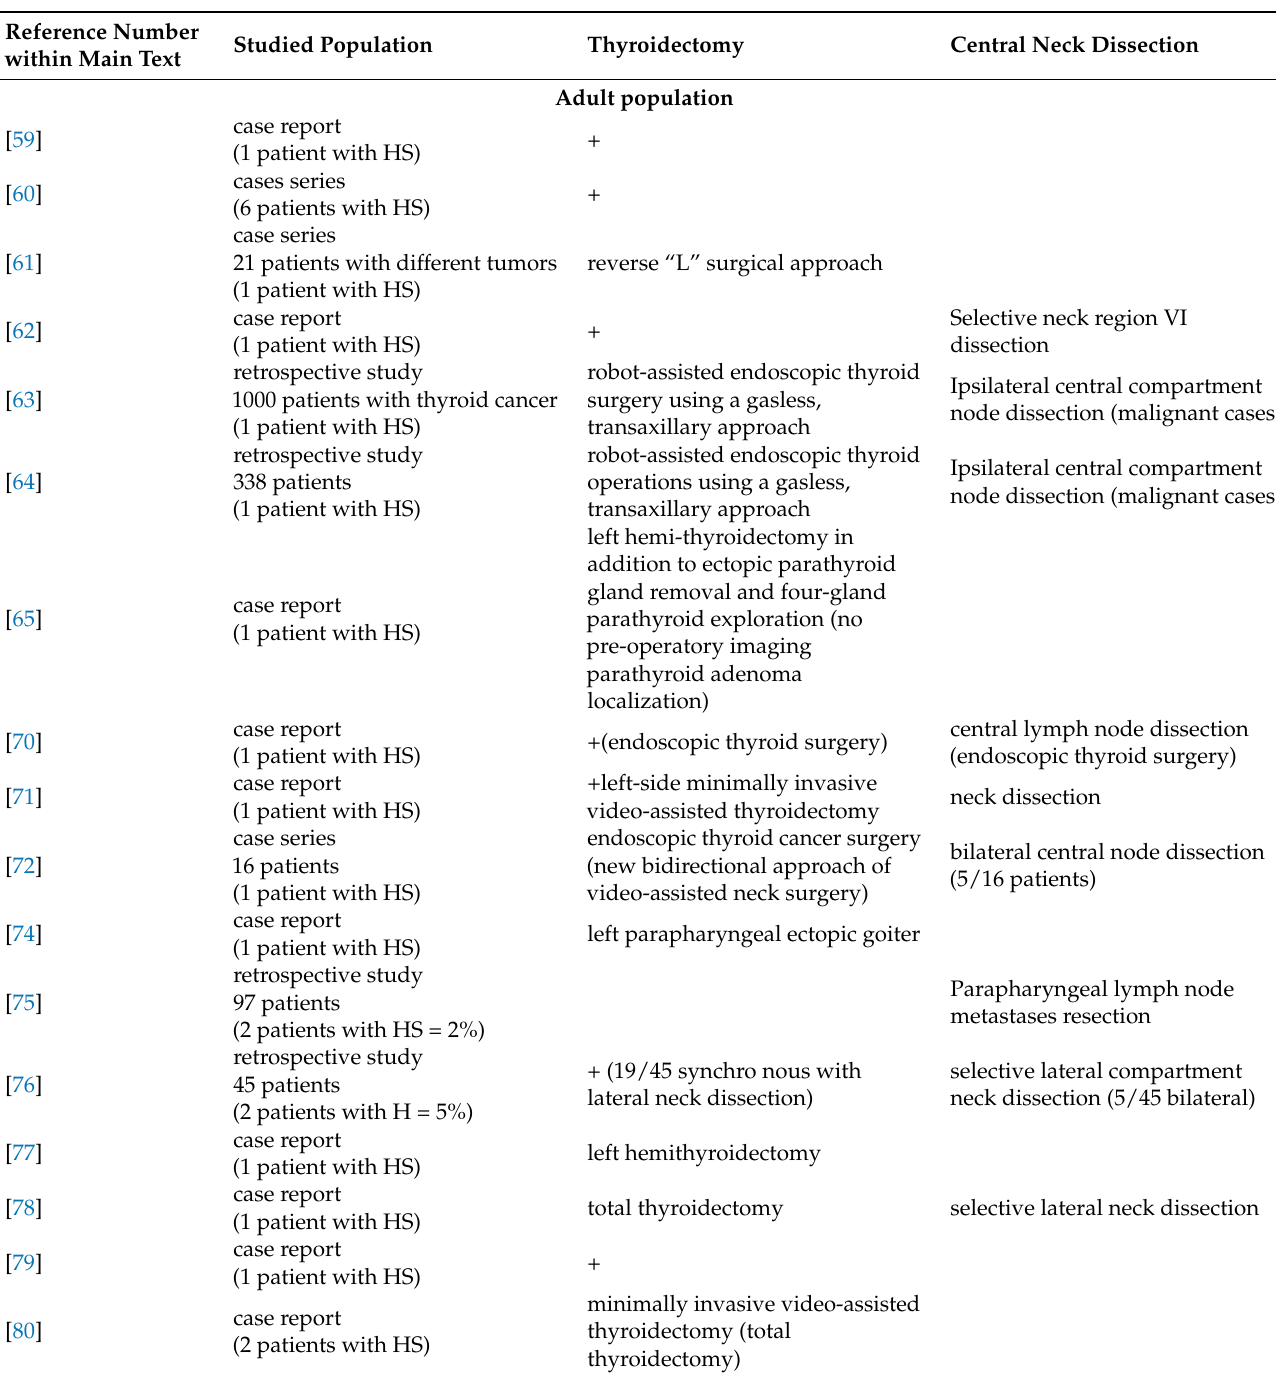
Table 1. Published papers concerning post-thyroidectomy Horner syndrome (the order of display is according to the main text body; please see references number: